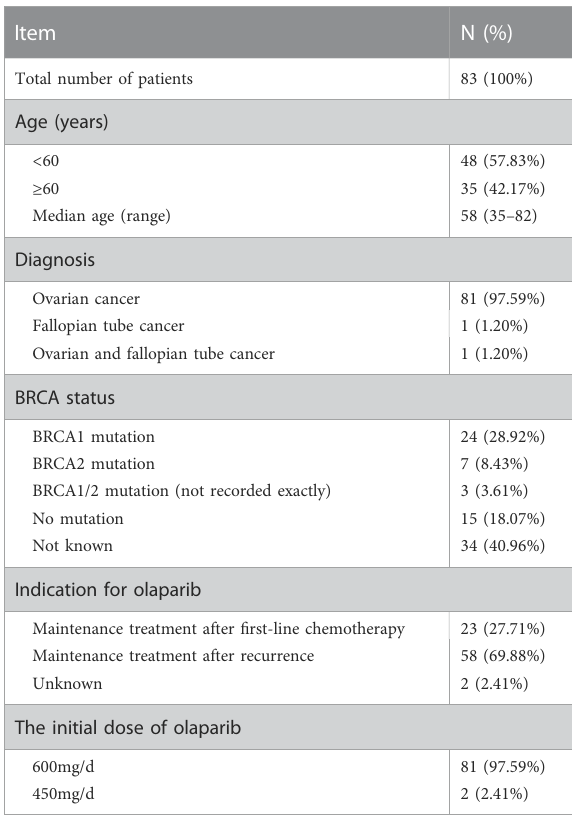
TABLE 1 Patients ’